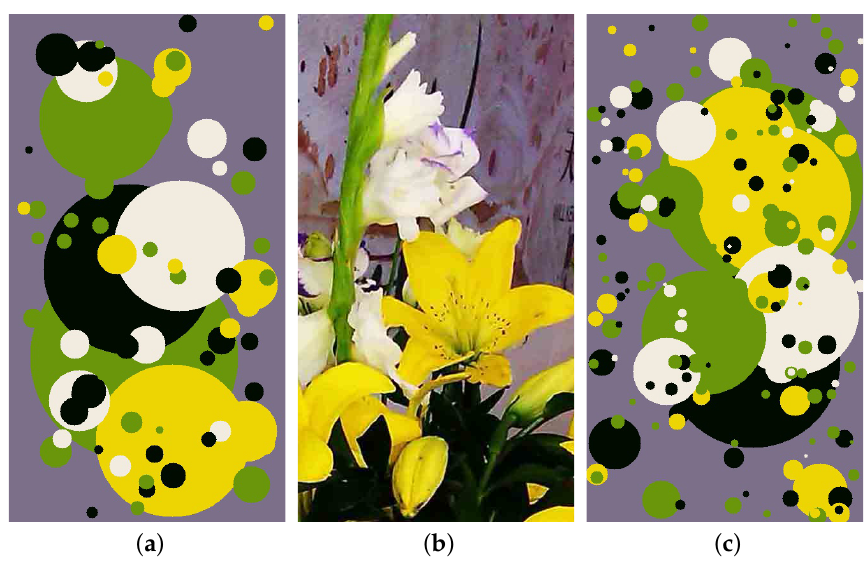
Figure 9. ( a ) Creation; ( b ) Original picture; ( c ) Creation.